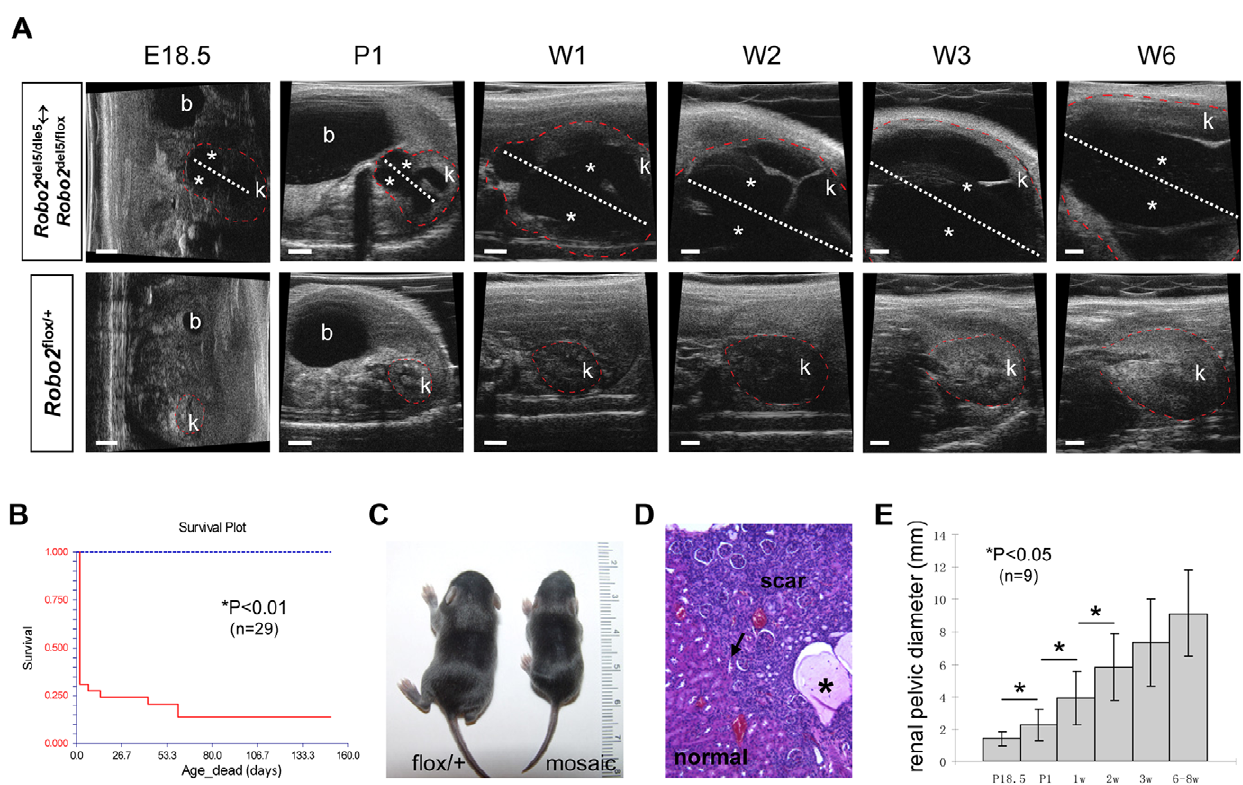
Figure 3. Natural history of antenatal hydronephrosis in Robo2 mosaic mice. ( A ) Upper figure panels: ultrasound noninvasive monitoring of hydronephrosis (asterisks) progression in a Robo2 mosaic mutant mouse from embryonic E18.5 to postnatal 6-week old (W6) showing no spontaneous resolution; white dot line representing the anteroposterior renal pelvic diameter. Lower figure panels: ultrasound noninvasive monitoring of a wild-type littermate control showing absence of hydronephrosis at any stages. The outline of the kidneys depicted in ultrasound images have been marked by red dot line. P1: postnatal day-1; W1 to W6: week-1 to week-6; b: bladder; k: kidney. ( B ) Survival curve of Robo2 mice with antenatal hydronephrosis (red line) compared with the survival curve of Robo2 mice without antenatal hydronephrosis (blue line). ( C ) Small body size of a Robo2 mosaic mouse with hydronephrosis at one week compared with its age matched wild-type littermate. ( D ) H&E histology of nephropathy and renal scar in a Robo2 mosaic mouse showing atrophic tubules, substantial inflammatory cellular infiltrate, degeneration of remnant glomeruli and proteinaceous casts (asterisk); there was a reflux nephropathy characteristic abrupt transition from scar tissue to relatively normal parenchyma (arrow in D). ( E ) The severity of hydronephrosis measured by the anteroposterior renal pelvic diameter at different stages from prenatal E18.5 to postnatal week-6 showing continuous progression of hydronephrosis in Robo2 mice without spontaneous resolution.